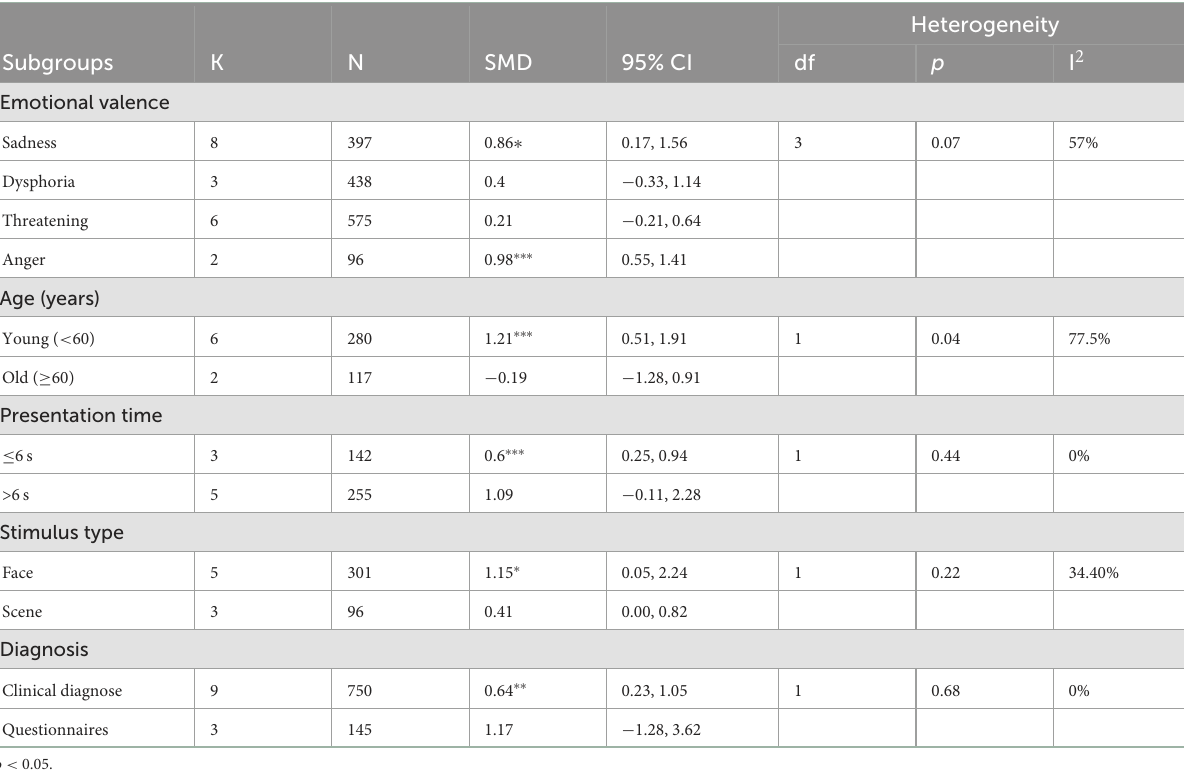
TABLE 3 Eye movement characteristics of patients with depression. Comparison